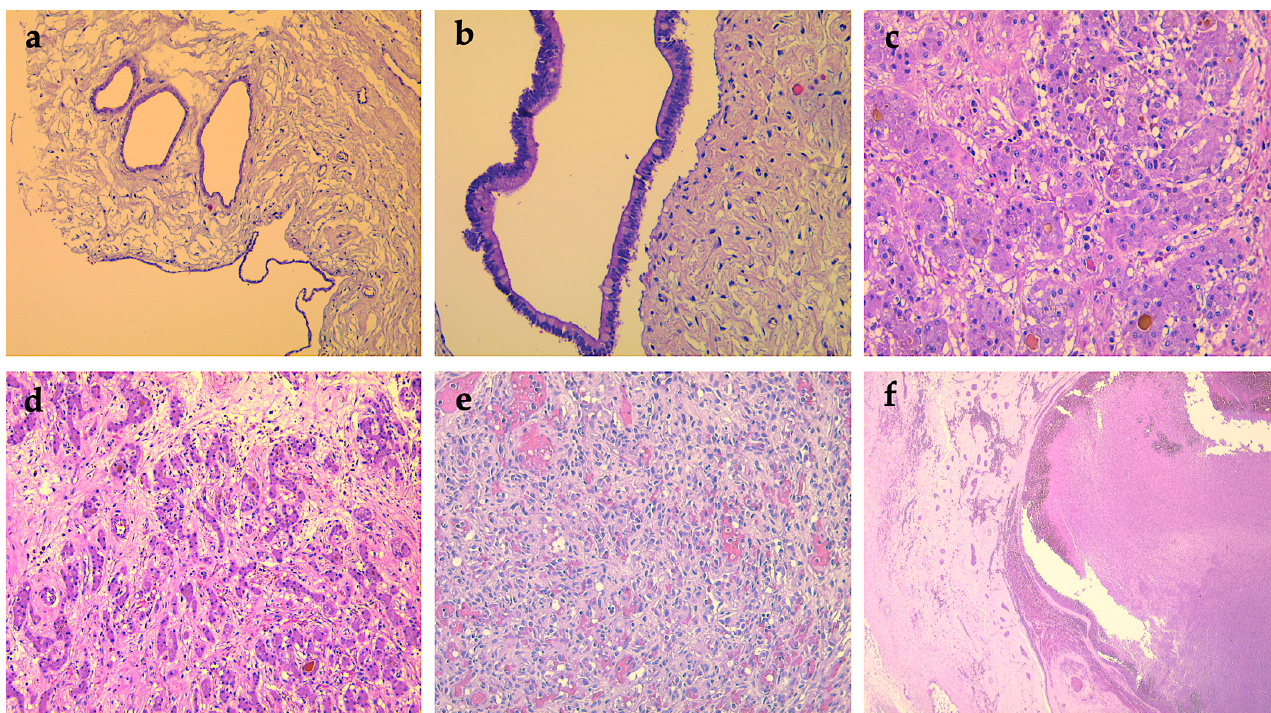
Figure 4. Histological findings of the pancreatic hamartoma, hepatoblastoma, and vena cava blocks. ( a ) Hamartoma of the pancreas: Cysts of variable sizes, lined by a single layer of cuboidal or columnar cells (H&E staining, ×100). ( b ) Hamartoma of the pancreas: Cyst with foveolar lining, punctuated by focal goblet-cell differentiation (H&E staining, ×200). ( c ) Hepatoblastoma: Nests of hepatocytes of the developing fetal liver, separated by fibrous stroma (H&E staining, ×100). ( d ) Hepatoblastoma: Thin trabeculae of hepatocytes forming pseudo acinar spaces with central bile plug (H&E staining, ×200). ( e ) Vessel wall: Granulation tissue with neoangiogenesis inside the vena cava wall (H&E staining, ×200). ( f ) Recent giant thrombus formed by fibrin and erythrocytes (H&E staining, ×25).